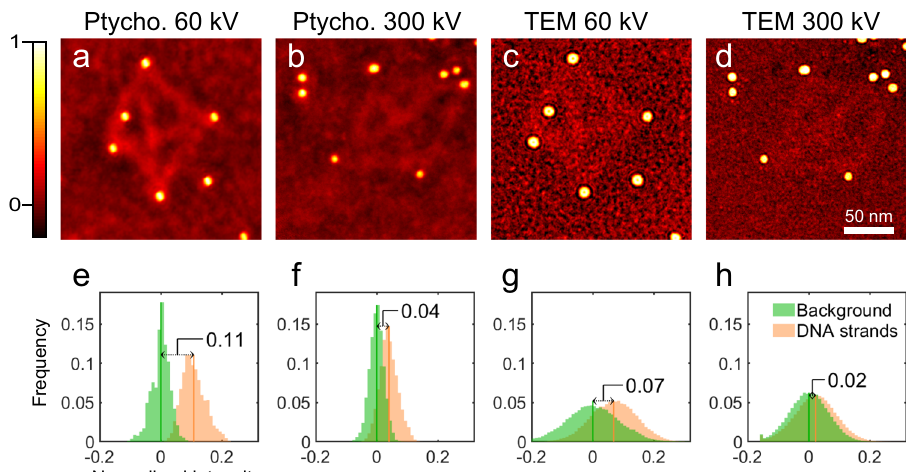
Fig. 4 | 2D ptychographic phases and TEM images at various accelerating vol- tages. a , b Normalised ptychographic phases at accelerating voltages of 60 and 300kV, respectively. c , d Normalised representative TEM images (from a set of